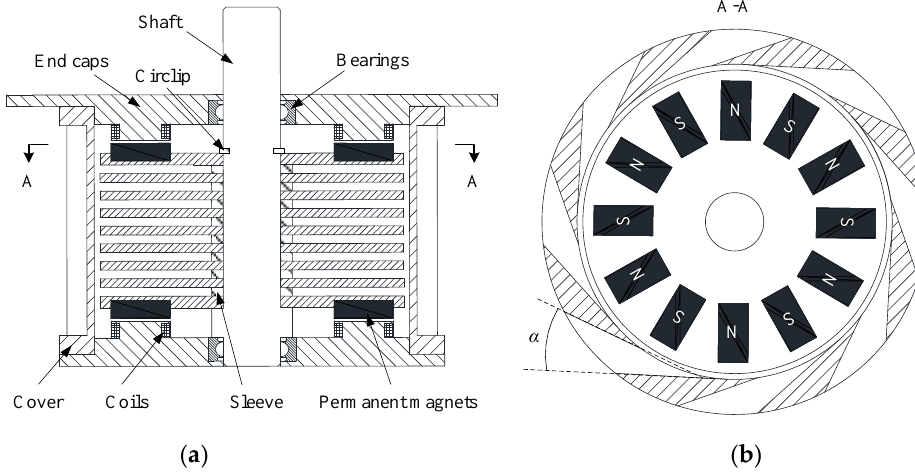
Figure 1. Schematic diagrams of the electromagnetic energy harvester. ( a ) Radial cross section. ( b ) Axial cross section.